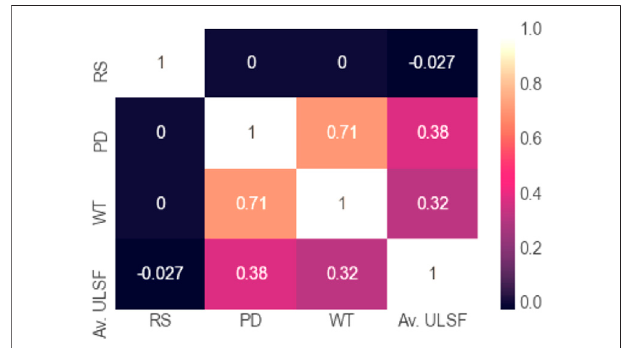
FIGURE 2 | Heatmap of the data.